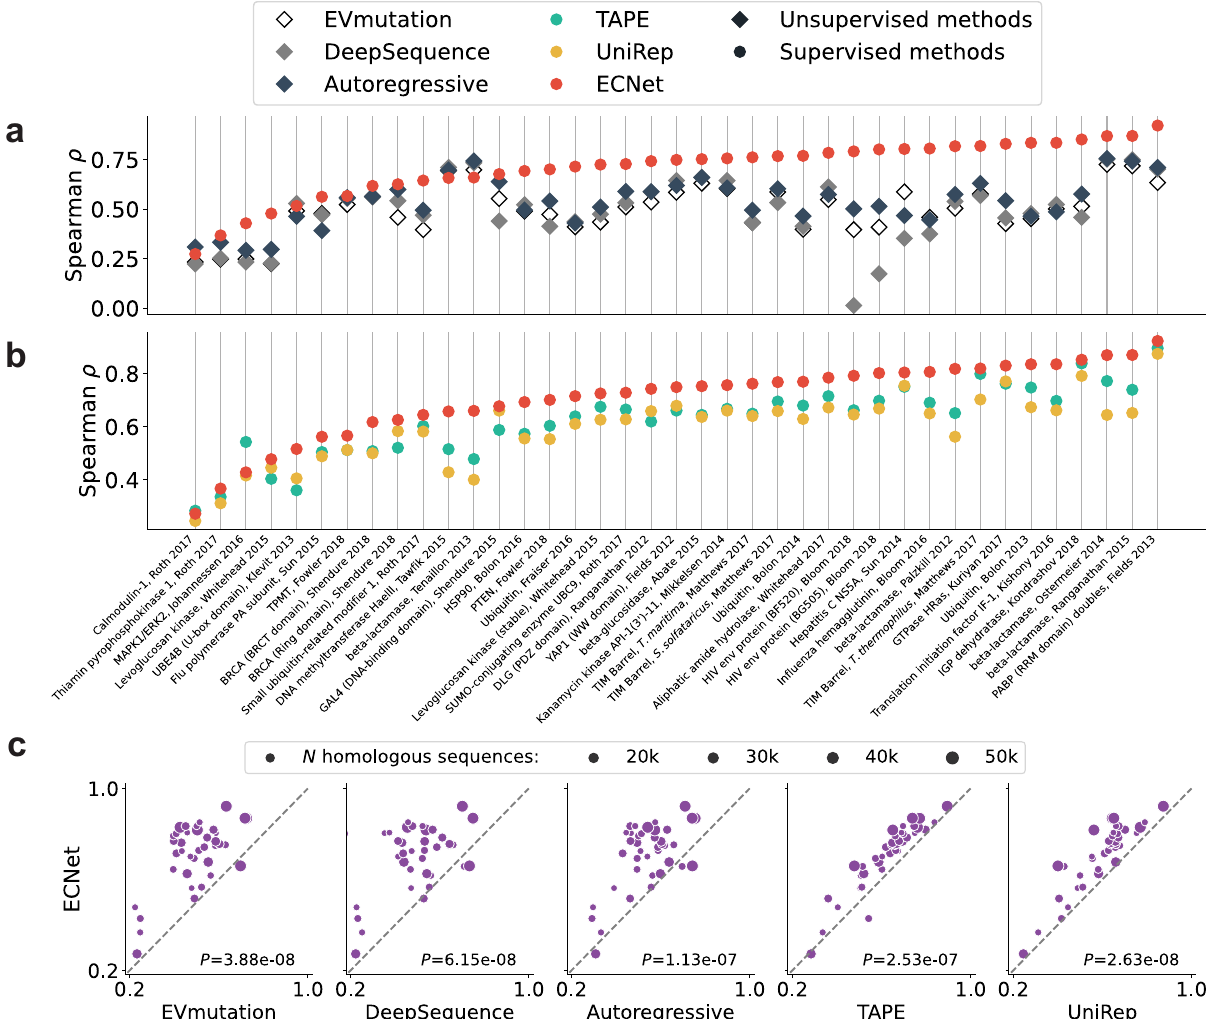
Fig. 3 Comparisons to other sequence modeling approaches for mutation effects prediction. a Comparisons to three unsupervised generative models, EVmutation, DeepSequence, and Autoregressive. b Comparisons to two supervised models (UniRep and TAPE) that use a pre-trained protein language model to learn protein sequence representations and fi ne-tunes a supervised predictor using functional measurements. c Pairwise comparisons between ECNet and other methods. Each data point represents the performance on the DMS data of a protein and the dot size is proportional to the number of homologous sequences of the protein. Spearman correlation was used as the evaluation metric for all results in this fi gure. One-sided rank-sum test was used to test the statistical signi fi